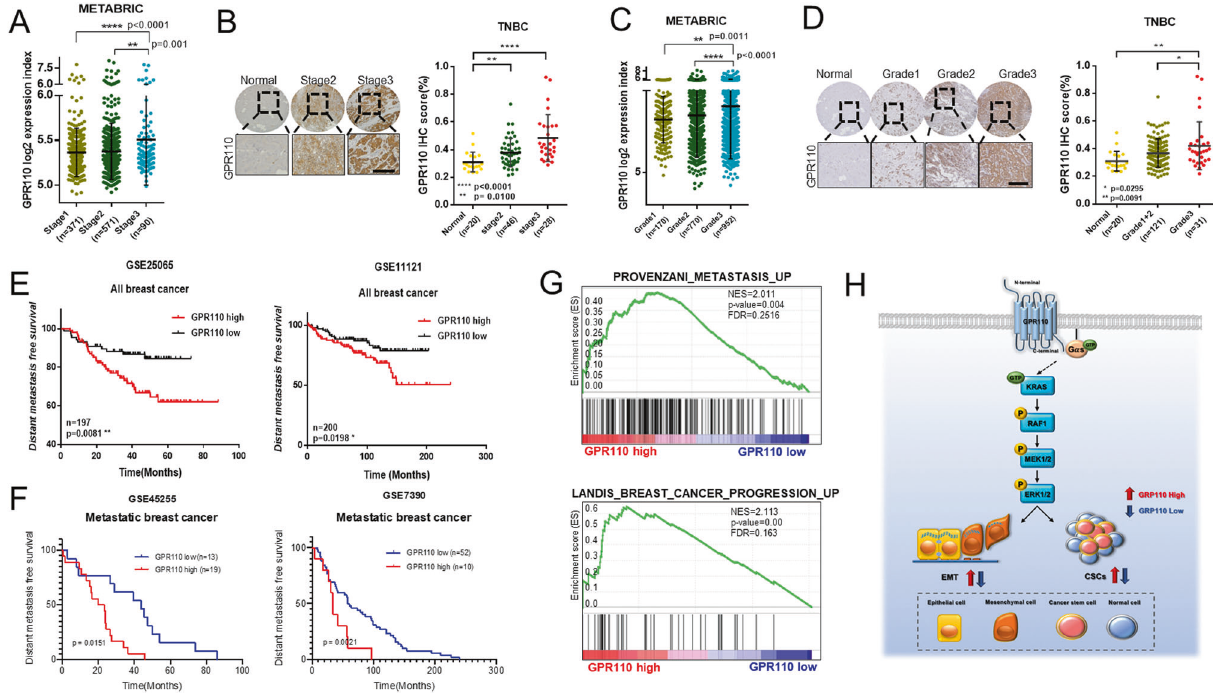
Fig. 5 GPR110 indicated a poor prognosis of breast cancer. A Graph showing GPR110 expression in stage1 ( n = 371), stage2 ( n = 571), and stage3 ( n = 90) of breast cancers using the database from METABRIC breast cancer databases. B Tissue microarray analysis of GPR110 expression in different stages of breast cancer (left) and the proportion is shown in the graph (right). C Graph showing GPR110 expression in grade1 ( n = 170), grade2 ( n = 770), and grade3 ( n = 952) of breast cancers using the database from METABRIC breast cancer databases. D Tissue microarray analysis of GPR110 expression in different grades of breast cancer (left) and the proportion in shown in the graph (right). E Kaplan – Meier survival analysis showed that high expression of GPR110 was associated with a poor survival rate of breast cancer patients obtained from the GEO database (GSE25085, GSE11121). F Kapan – Meier survival analysis of metastatic breast cancer patients (GSE45255, GSE7390). G GSEA of metastasis and cancer progression signature to GPR110 expression in breast cancer patients. H Schematic of